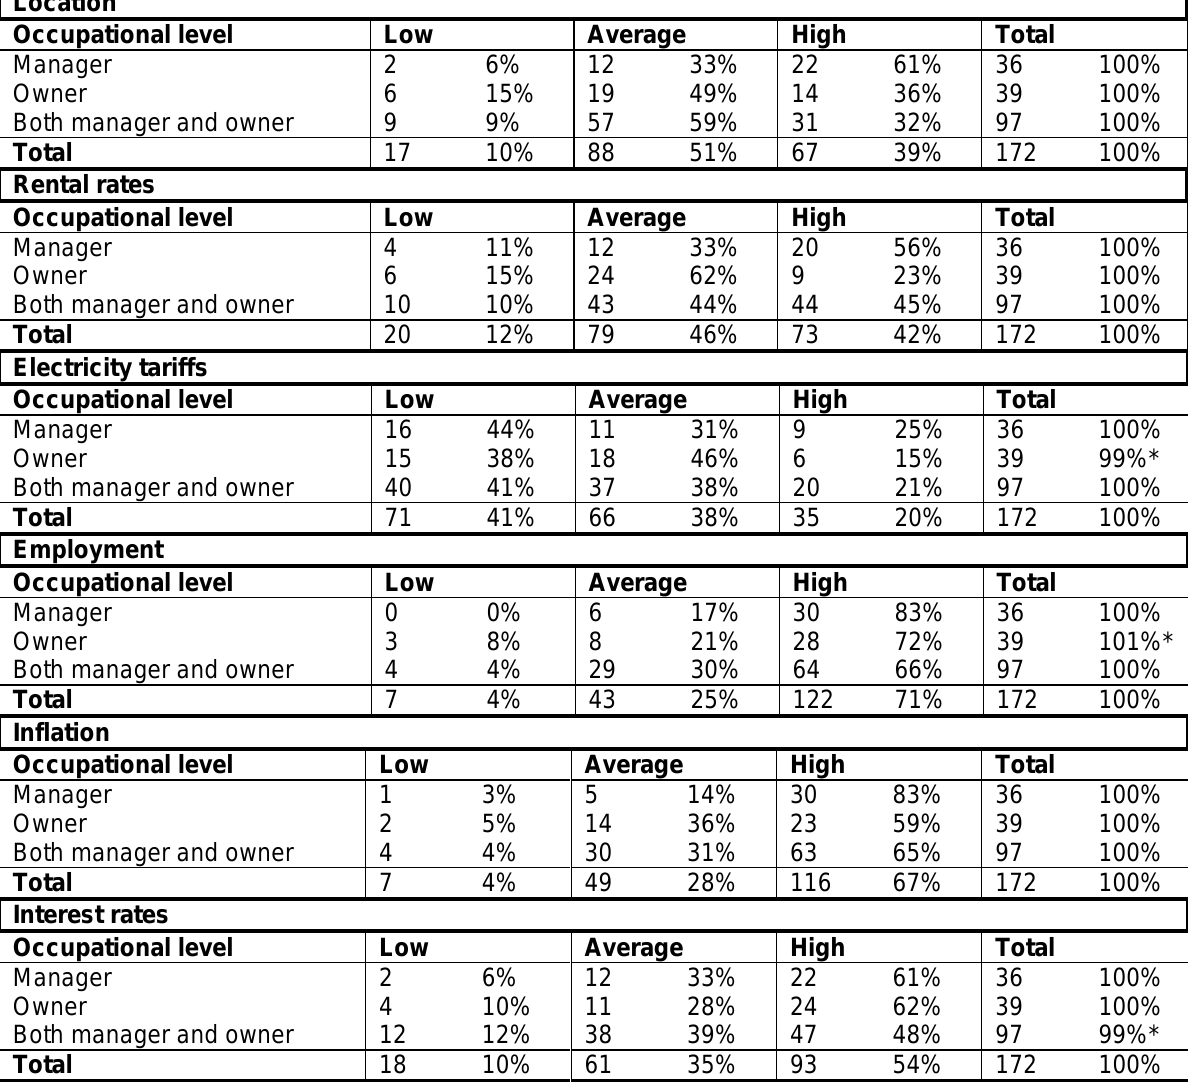
Table 3: Frequency distribution of occupational level versus